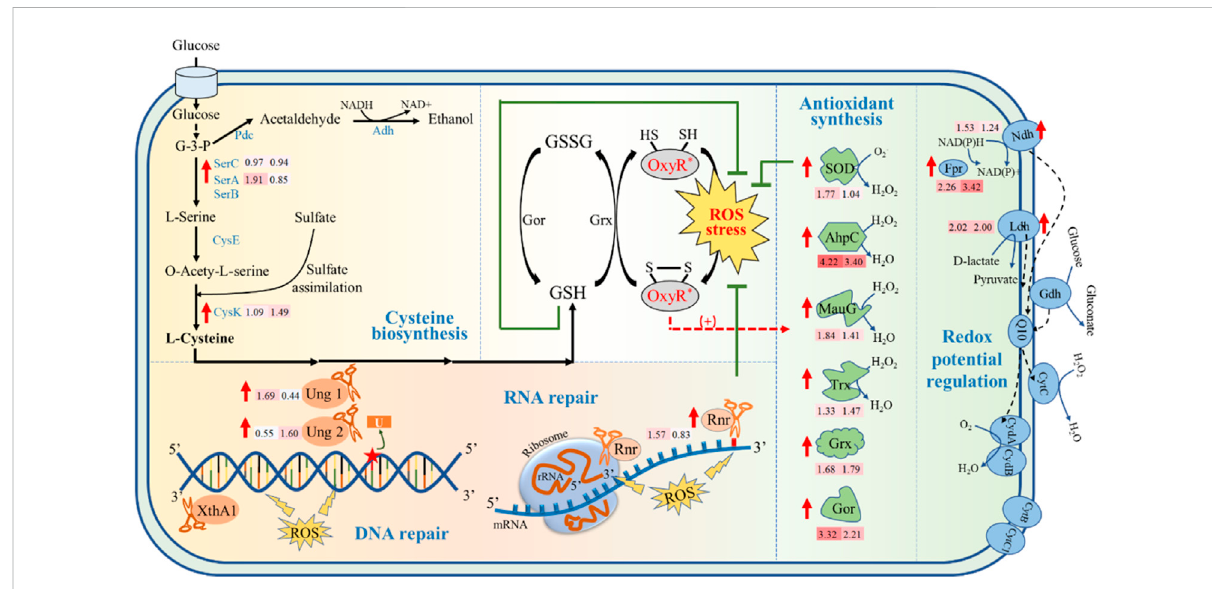
FIGURE 4 Potential molecular mechanism of inhibitor tolerance of ZMNP. AhpC: Alkyl hydroperoxide reductase, Fpr: Ferredoxin-NADP (+) reductase, Gor: Glutathione reductase, Grx: Glutaredoxin, GSH: Reduced glutathione, GSSG: Oxydized glutathione, G-3-P: Glyceraldehyde 3-Phosphate, Ldh: Lactate dehydrogenase, MauG: Cytochrome-c peroxidase, Ndh: FAD-dependent pyridine nucleotide-disul fi de oxidoreductase, Rnr: Ribonuclease R, SOD: Superoxide dismutase, Trx: Thioredoxin, Ung: Uracil-DNA glycosylase, XthA1: Exodeoxyribonuclease III